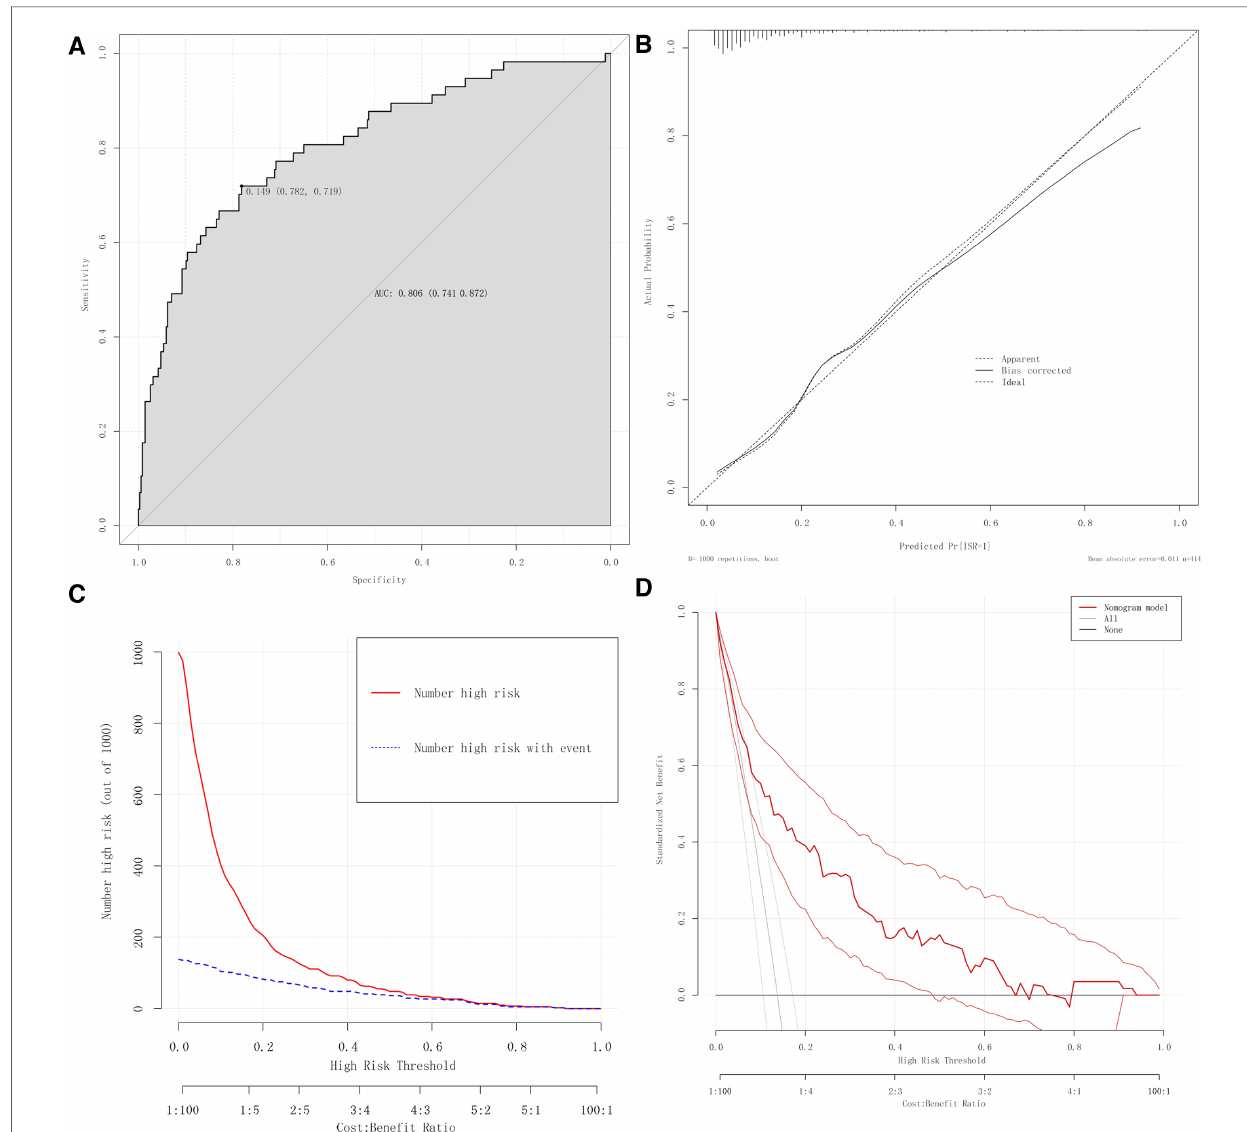
FIGURE 6 Evaluation of the nomogram prediction model. (A) ROC curves of the nomogram. (B) Calibration plots of the nomogram. (C) CIC of the nomogram. (D) DCA of the